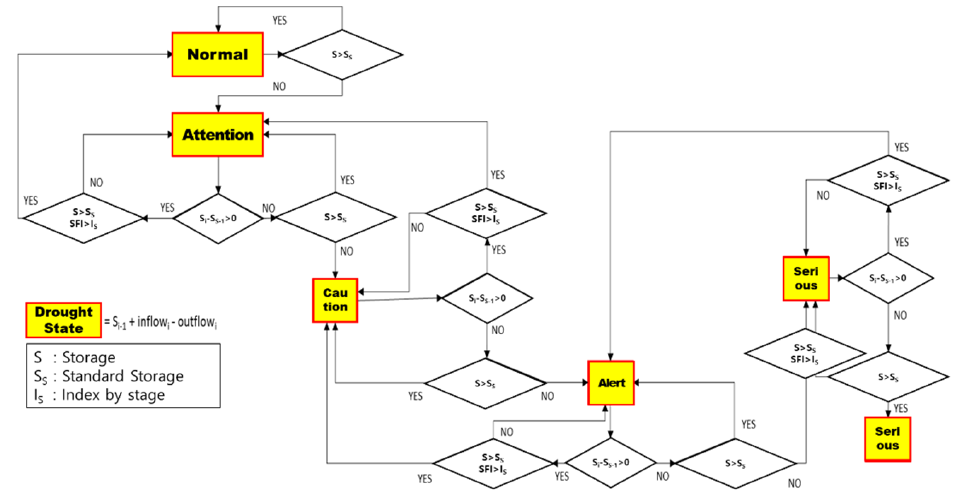
Figure 2. Schematic of the simulation for termination criteria for water supply by drought response